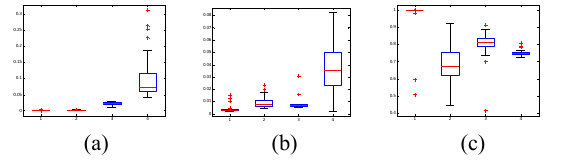
Fig. 16. Box plots for the metrics of generational distance (a), Fig. 14. Box plots for the metrics of generational distance (a), spacing (b), maximum spread(c), KMOPSO (1), NSGA-II (2), spacing (b), maximum spread(c), KMOPSO (1), NSGA-II (2), MOPSO (3), MOPSO-CD (4). MOPSO (3), MOPSO-CD (4). Table 20 . Results of the generational distance metric for Table 17 . Results of the generational distance metric for ZDT6. ZDT4.